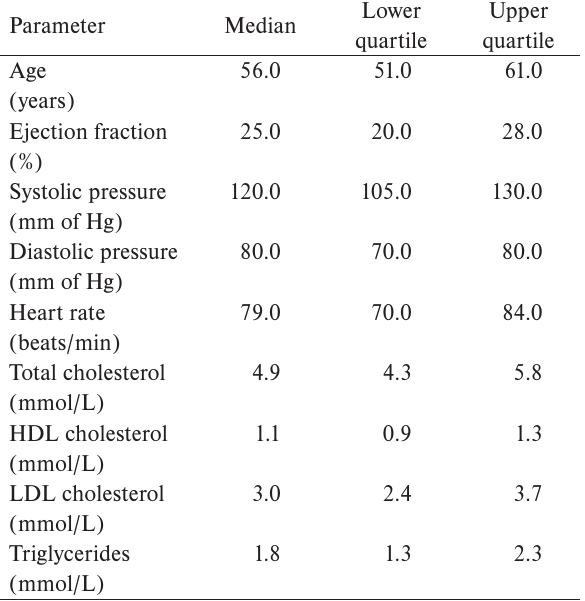
Table 1. Basic characteristics of patients with heart failure.